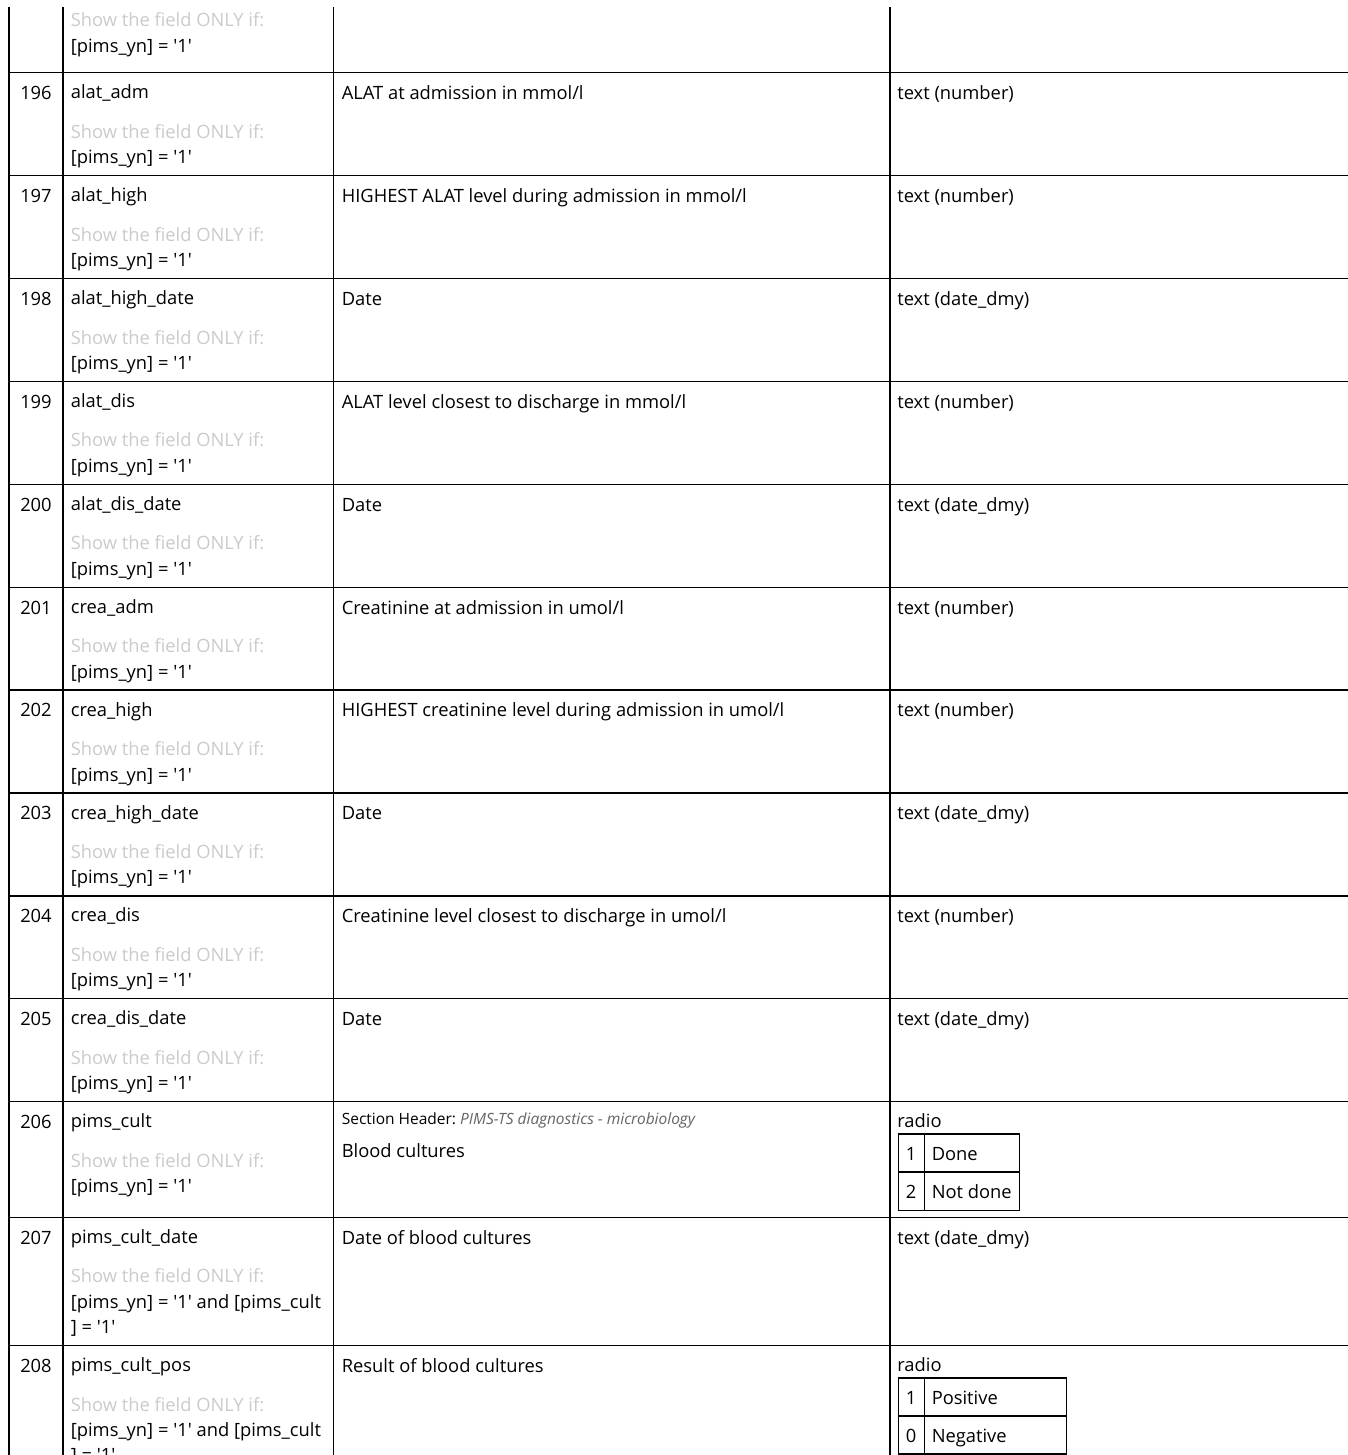
Speci ! y bacteria found in blood cultures text